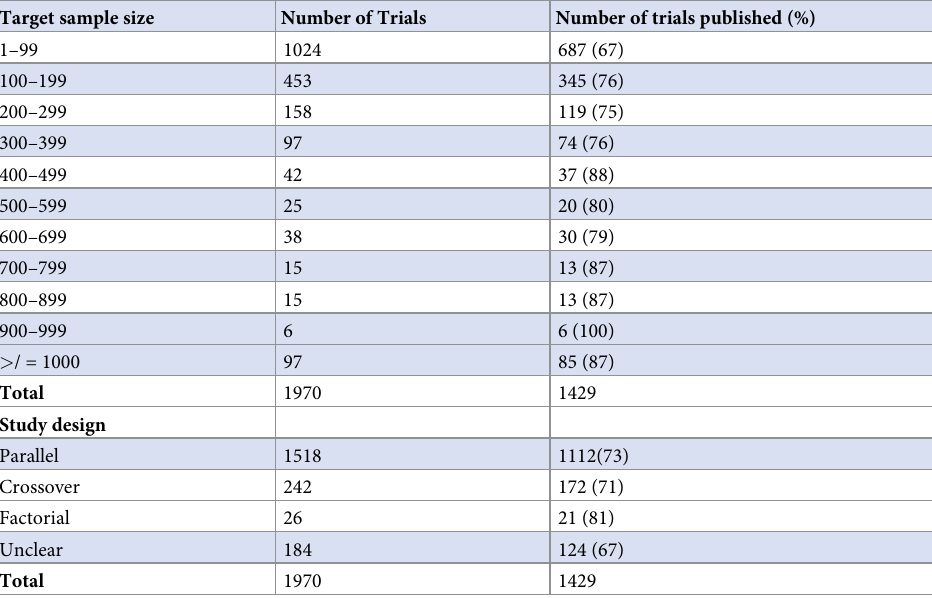
Table 1. Target sample size and study design of ANZCTR registrations 2007, 2009, and 2011 (n =